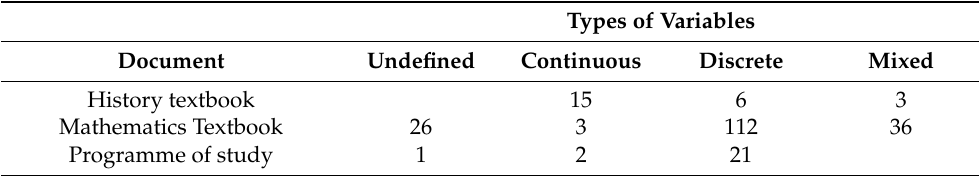
Table 4. Types of variables mobilised in the 10th grade tasks (Source: Prepared by the authors).